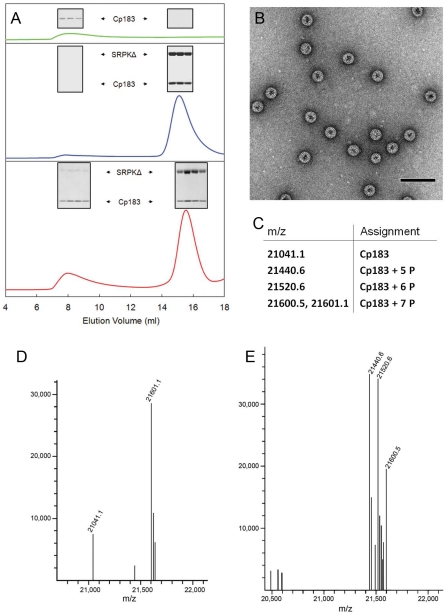

In vitro SRPKΔ-gated HBV capsid assembly.SRPKΔ was used as an in vitro chaperone to prevent Cp183 aggregation and regulate Cp183 self-assembly. (A) Size exclusion chromatographs of Cp183 capsid assembly products. The insets show SDS-PAGE of the indicated SEC fractions. Cp183 capsid assembly was normally induced by dialyzing GuHCl from Cp183 dimer solution, resulting in reassembled capsid eluting at ∼8 ml and a significant loss of Cp183 to precipitation (green). Mixing SRPKΔ and Cp183 dimer prior to dialysis prevented aggregation or capsid assembly; instead a stable soluble complex formed and eluted at ∼15 ml (blue). Subsequent dialysis of the Cp183 capsid/SRPKΔ complex against ATP/Mg++ resulted in a mixture of capsid, complex, and presumably free SRPKΔ (red). (B) Negative stained TEM of the capsid fraction from an SRPKΔ-gated Cp183 assembly reaction shows morphologically normal HBV capsids. The majority of the particles are ∼35 nm in diameter with a minor ∼30 nm diameter population. The scale bar is 100 nm. (C) Table of species identified in the mass spectra shown in panels d and e. (D) MS of the capsid fraction from an SRPKΔ-gated assembly reaction. Most of the Cp183 from the capsid fraction was phosphorylated at seven sites, with a relatively small portion of unphosphorylated and partially phosphorylated protein. (E) MS of the lower molecular weight complex fraction after SRPKΔ-gated assembly. Most Cp183 was phosphorylated at 5 to 7 sites; the relatively large fraction of partially phosphorylated Cp183 in this pool suggests that it is more likely to remain bound to SRPKΔ.